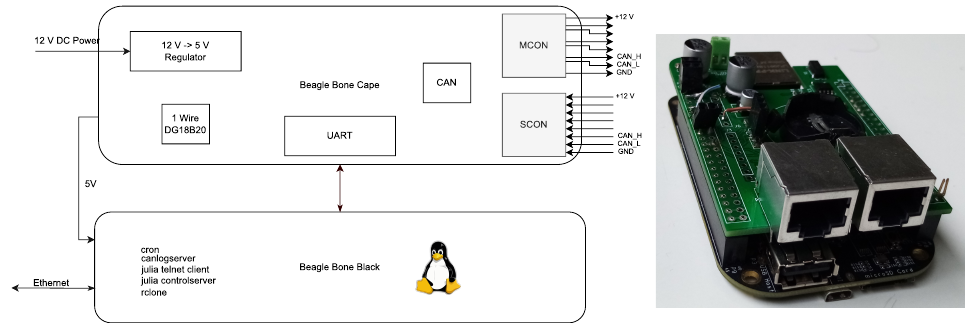
Figure 8. The block diagram of a system gateway based on the Beagle Bone Black with the cus- tom